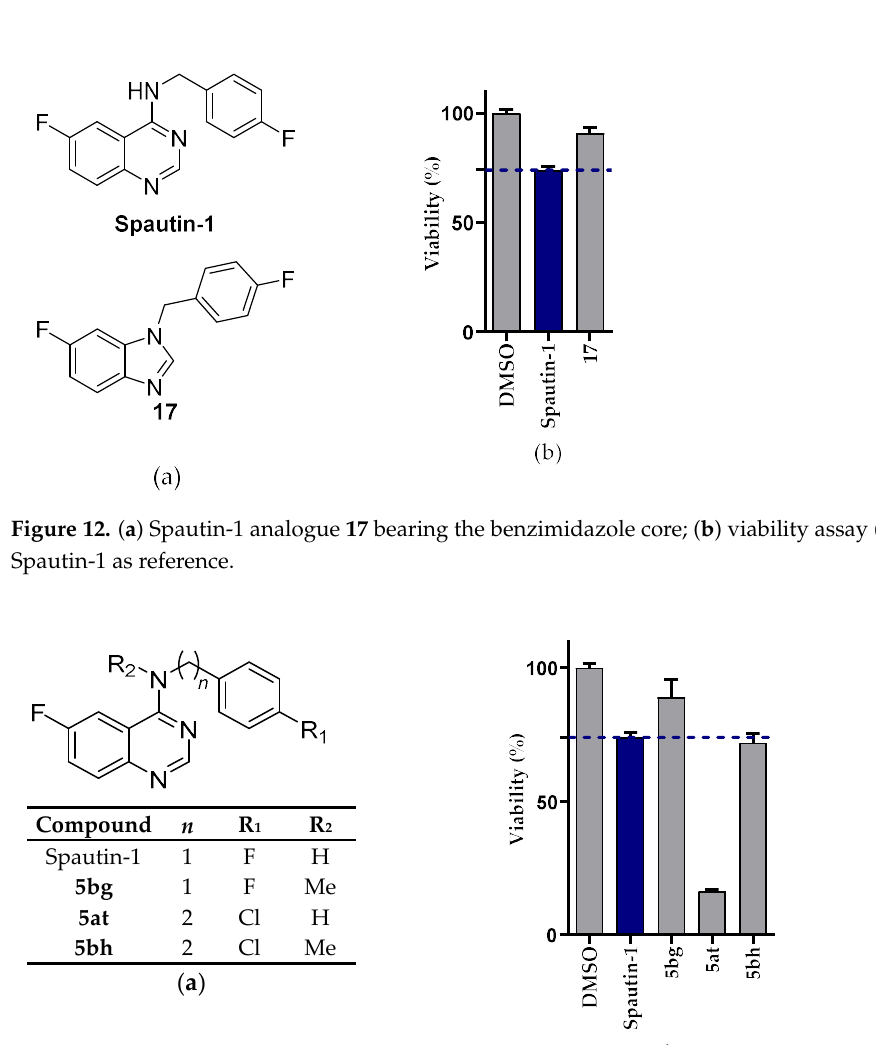
Figure 13. ( a ) Alkylation of the secondary amine; ( b ) viability assay (5µM) with Spautin-1 as refer-